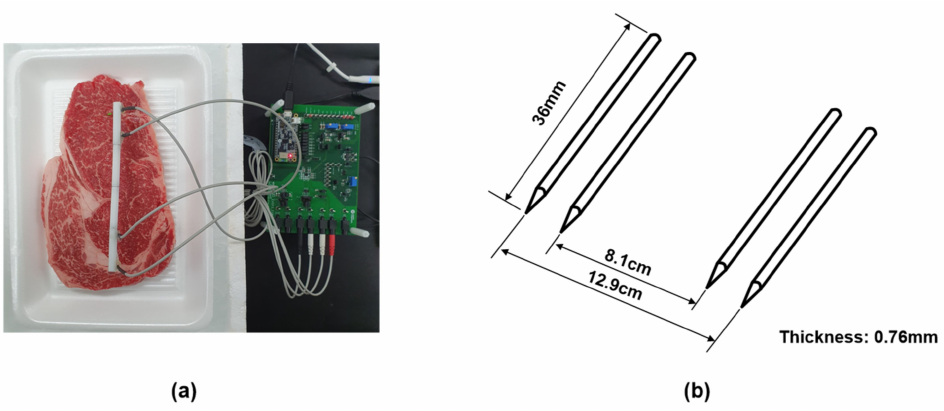
Figure 4. ( a ) The settings for the measurement. ( b ) Schematic diagrams of tetrapolar